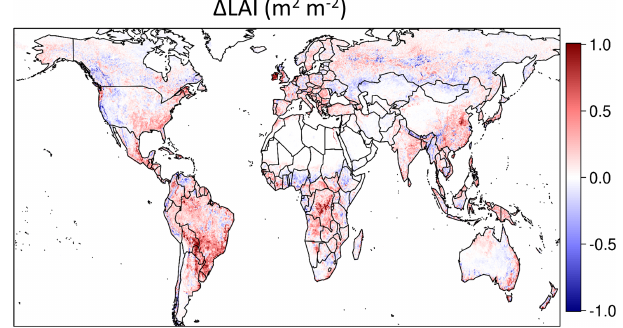
Figure 2. Changes in 3-year mean annual leaf area index (LAI) derived from the Global Land Surface Satellite (GLASS) (2012 to 2014 average minus 1991 to 1993 average).